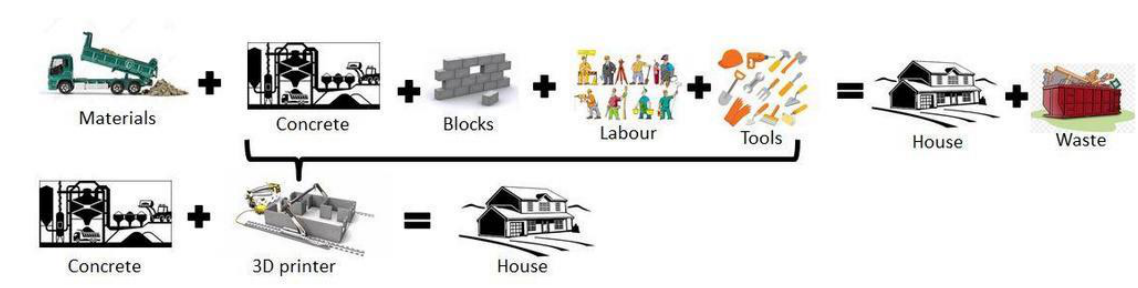
Figure 1: Traditional construction process vs 3D printing